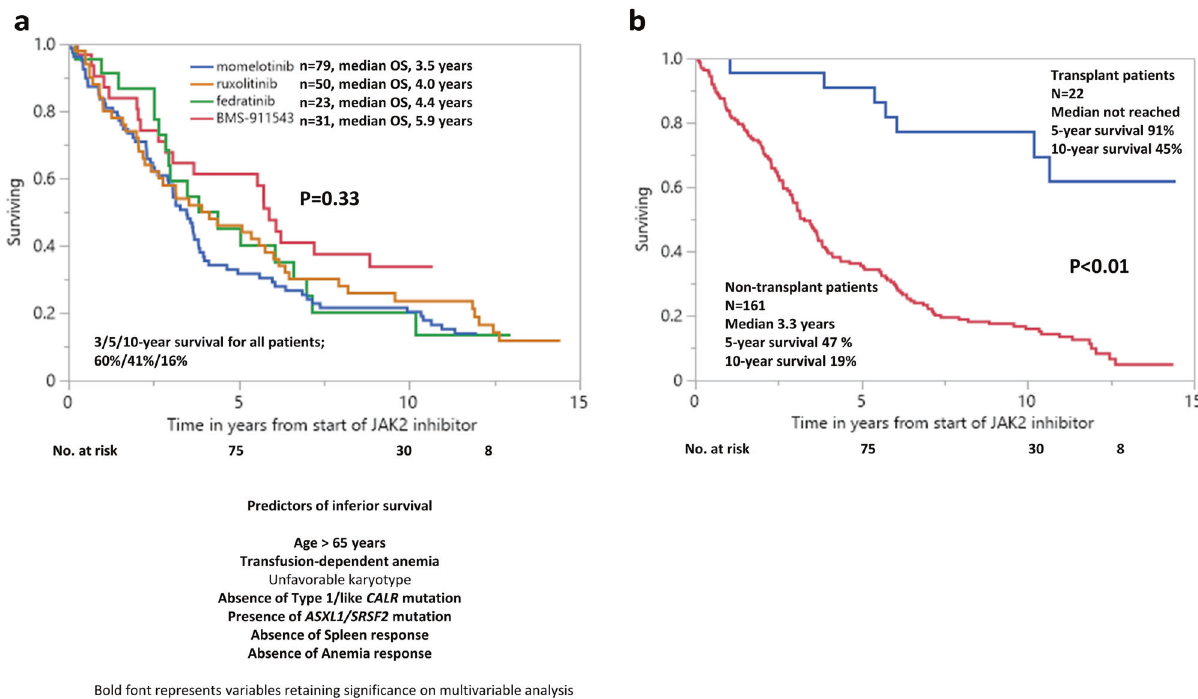
Fig. 1 Post-treatment survival of 183 JAK2 inhibitor-naive patients with myelo fi brosis receiving JAK2 inhibitors in the context of clinical trial. a Post-treatment survival of 183 JAK2 inhibitor-naive patients with myelo fi brosis receiving JAK2 inhibitors in the context of clinical trials, strati fi ed by speci fi c drug, b Post-treatment survival of 183 inhibitor-naive patients with myelo fi brosis receiving JAK2 inhibitors in the context of clinical trials, strati fi ed by allogeneic